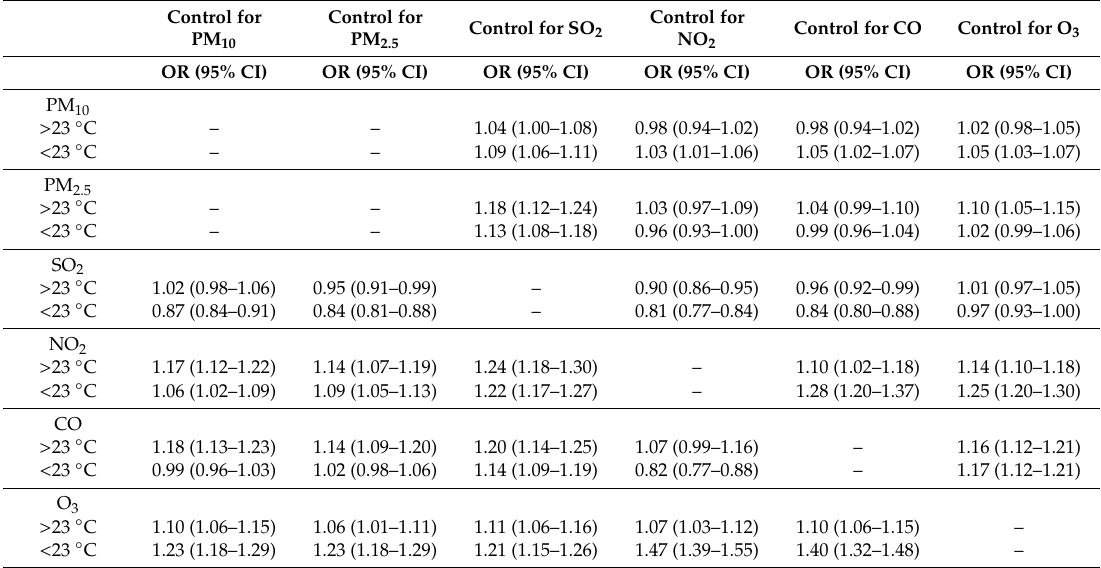
Table 4. Risk of peptic ulcer admissions per IQR increase in two-pollutant model by temperature a,b . Control for Control for Control for Control for SO 2 Control for CO Control for O PM 10 PM 2.5 NO 2